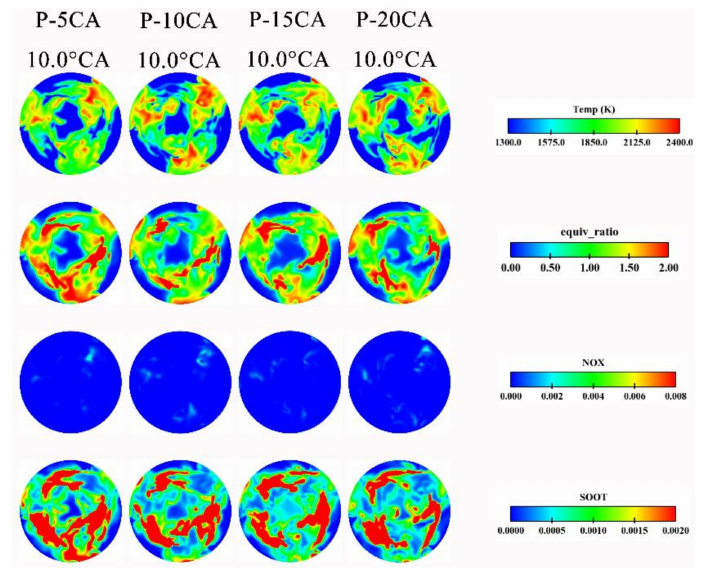
Figure 13. Impact of pilot injection timing on the distribution of temperature, fuel-air equivalence ratio, NOx formation, and soot formation at the moment of q50 for various injection